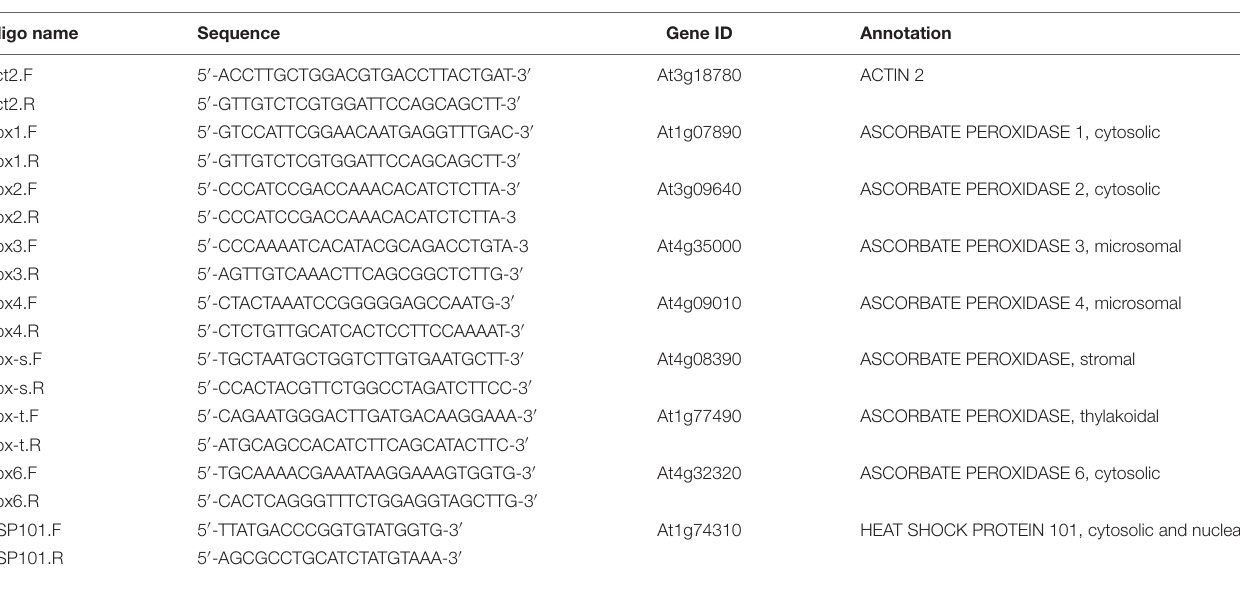
TABLE 1 | Sequences used for qPCR